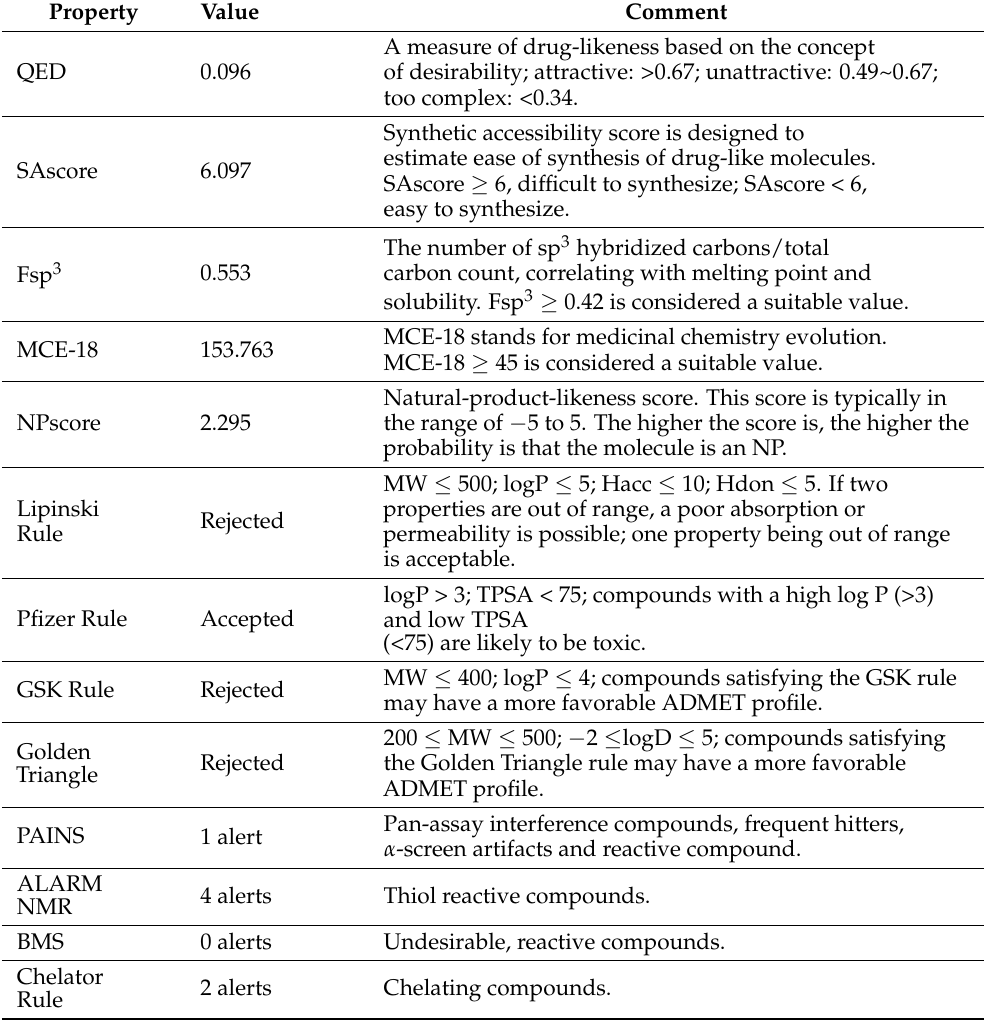
Table 7. Medicinal chemistry of compound 1 .